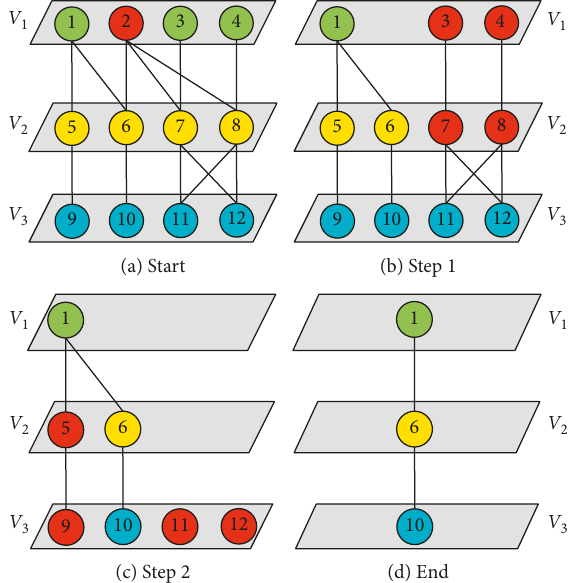
Figure 6: Proposed model M2 for depicting the cascading failures of a multipartite network subject to node attacks. (a) Initially, node 2 of partite set V is attacked. (b) The removal of node 2 fragments 1 and V and nodes the bipartite network containing partite sets V 1 2 outside the LCC will be removed. (c) The removal of nodes 7 and 8 fragments the bipartite network containing partite sets V and V 2 3 and nodes outside the LCC will be removed. (d) Eventually, only nodes 1, 6, and 10 (or 1, 5, and 9) survive the attack of node